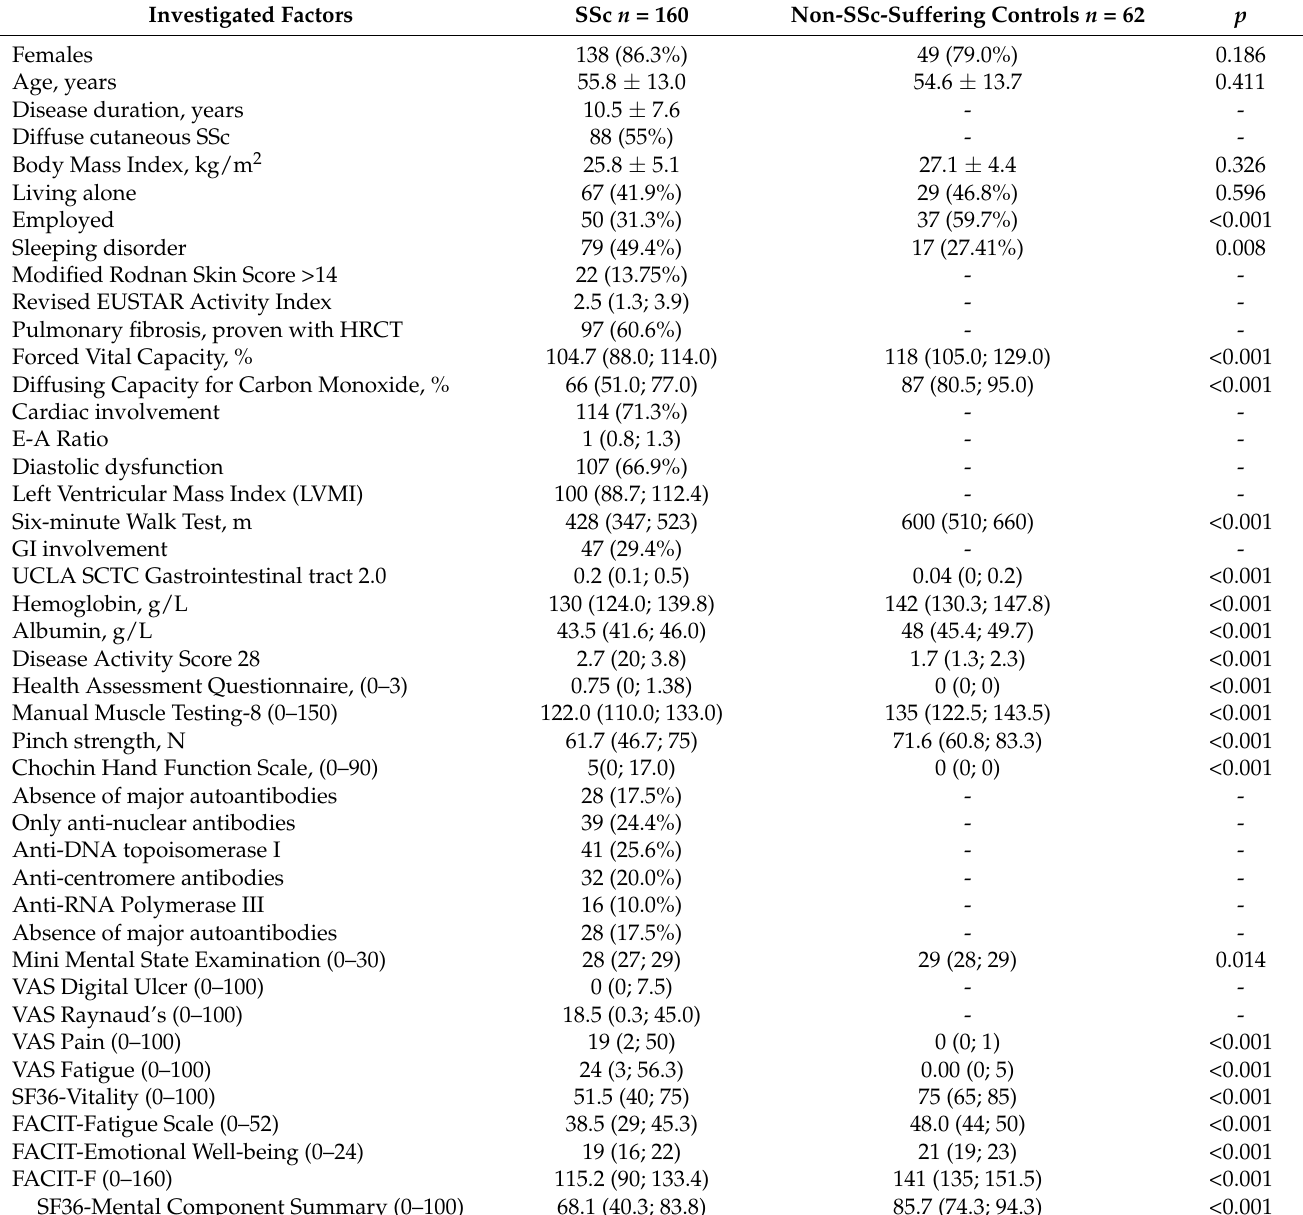
Table 1. Clinical and demographical characteristics of 160 patients afflicted with Systemic Sclerosis (SSc) and 62 non-SSc-suffering control